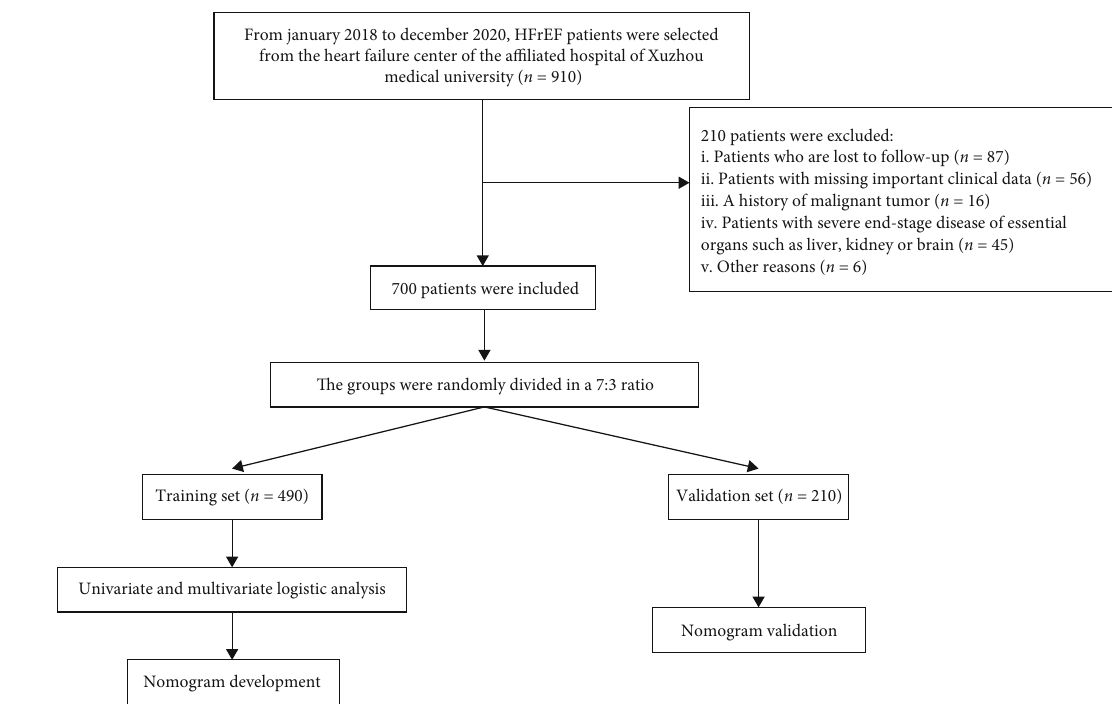
Figure 1: Flow chart of inclusion and exclusion process of HFrEF